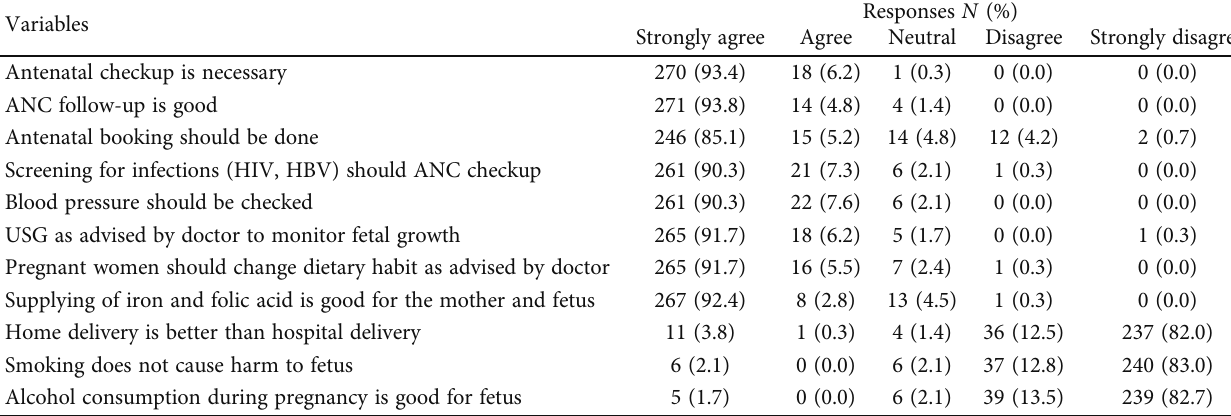
Table 3: Attitude of pregnant women on antenatal care in Amatere Health Center, Massawa, Eritrea.